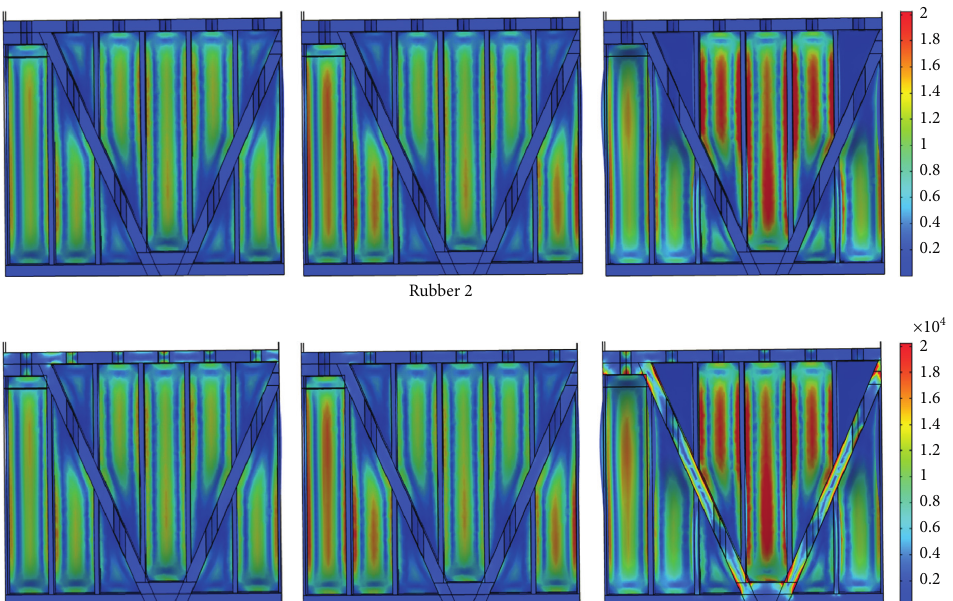
Figure 14: Structure deformation (amplified) and stress modes of each pure (upper) and composite rubber 2 structure at 25, 985, and 1465Hz (left to